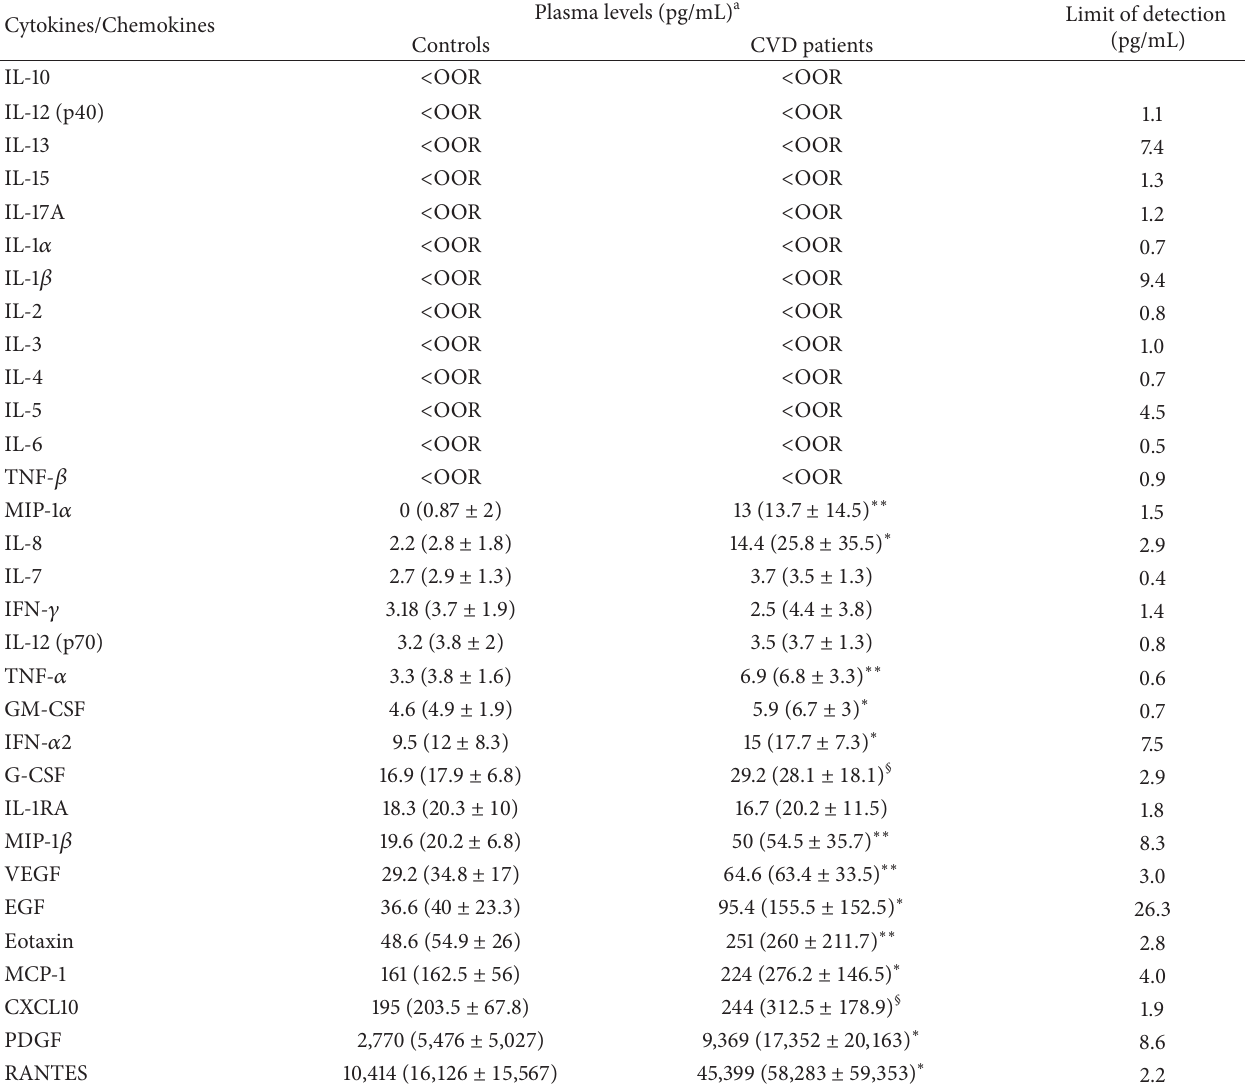
Table 1: Circulating levels of cytokines/chemokines and growth factors in healthy controls and CVD patients. Plasma levels (pg/mL) Cytokines/Chemokines